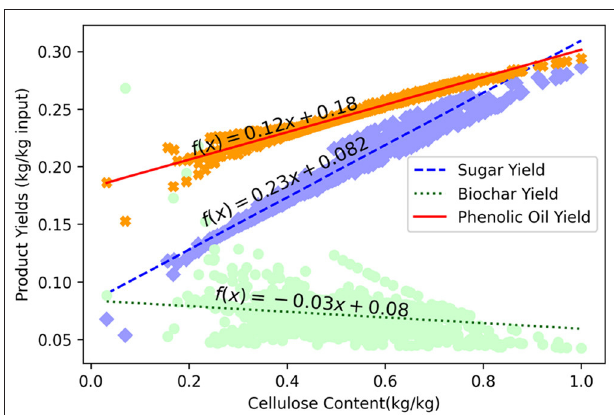
FIGURE 4 | Sugar, biochar, and phenolic oil autothermal pyrolysis yield vs. cellulose content.